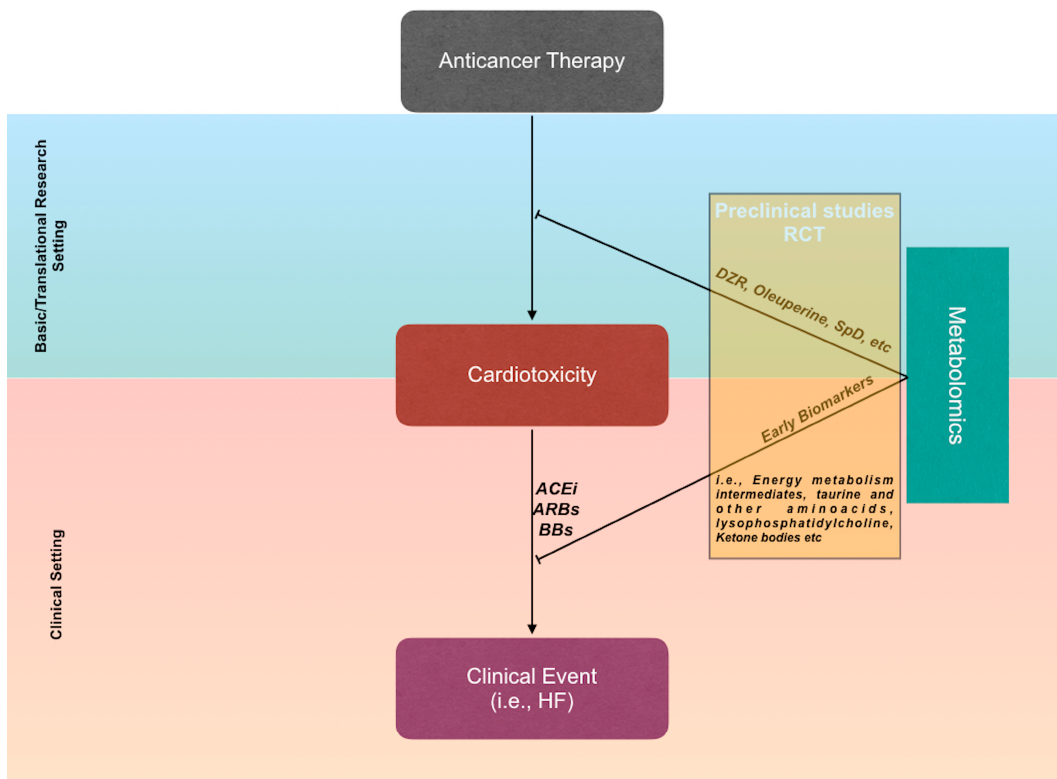
Figure 2. Future challenges of metabolomic studies. Translational research could accelerate the development of cardioprotective agents to be introduced rapidly in clinical practice. On the other hand, the identification of metabolite clusters associated with the risk of developing cardiotoxicity (CTX) could allow an early therapeutic intervention, before the occurrence of clinical events. Abbreviations: RCT: randomised clinical trials; ACEi: ACE-